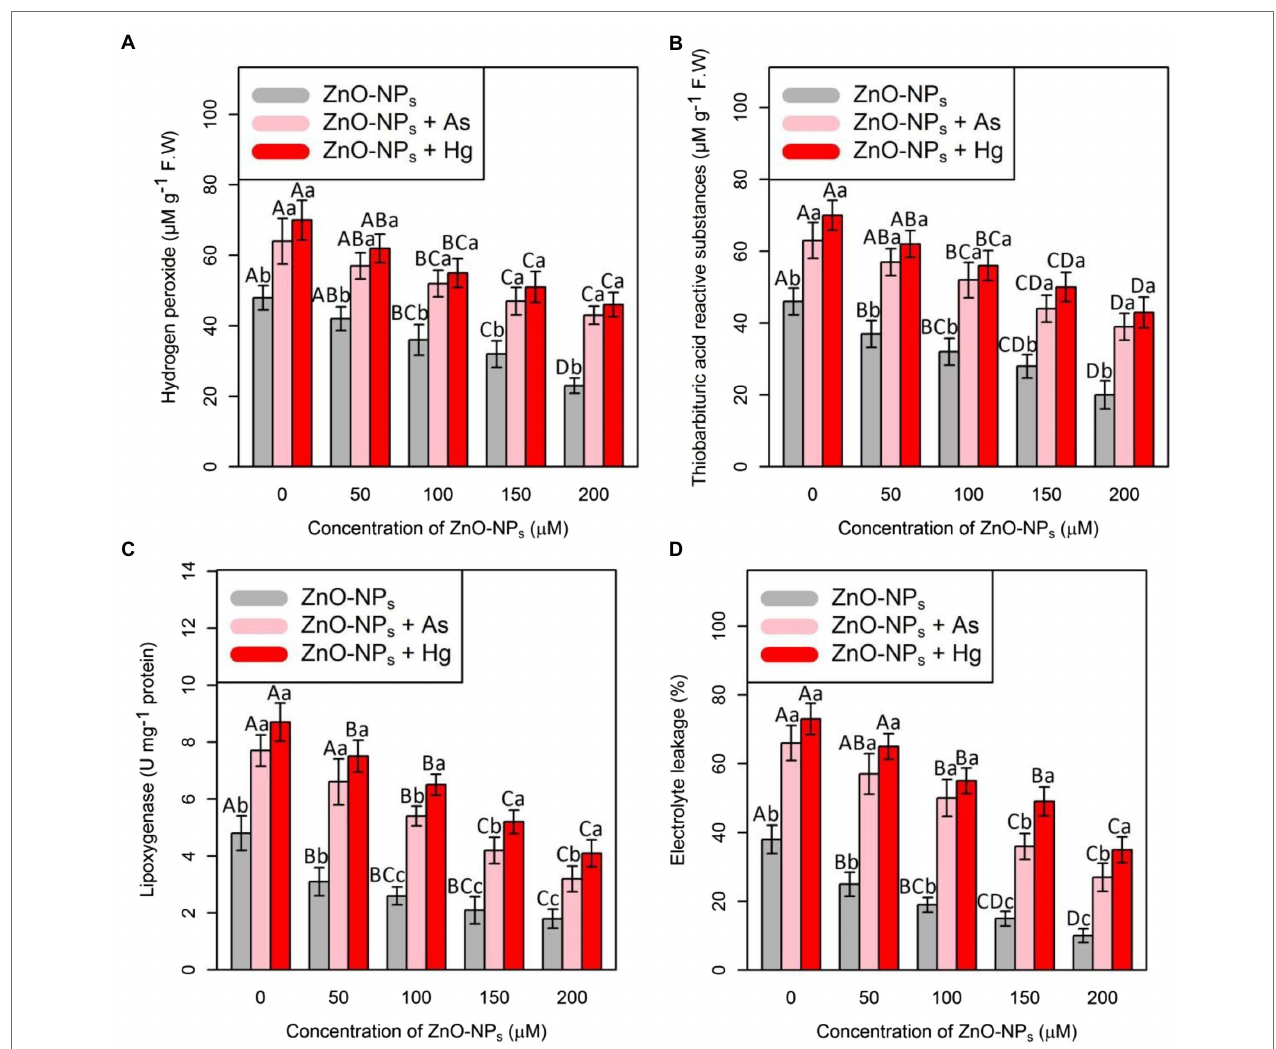
FIGURE 3 | The impact of ZnO-NPs concentrations on (A) hydrogen peroxide (H 2 O 2 ) content, (B) thiobarbituric acid reactive substances (TBARS), (C) lipoxygenase activity (LOX), and (D) electrolyte leakage (EL) in bamboo species ( Pleioblastus pygmaeus ) with 150 μ M As and 150 μ M Hg. The capital letters indicated statistically significant differences across various concentration of ZnO-NPs alone or in combination with 150 μ M As and 150 μ M Hg (the bars with the same colors), while the lowercase letters indicated statistically significant differences within each level of ZnO-NPs alone or in combination with 150 μ M As and 150 μ M Hg (the bars with different colors) according to Tukey’s test ( p <